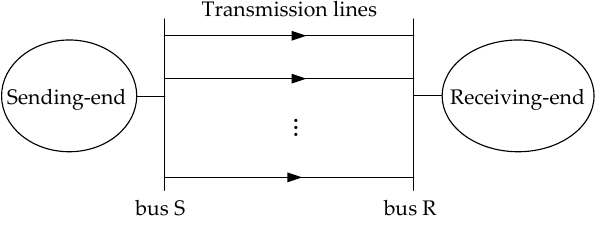
Figure 1. Schematic diagram of a system composed of the sending-end and the receiving-end with transmission lines connecting them.